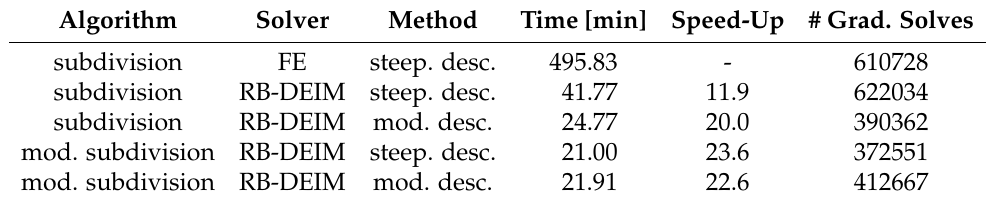
Table 6. Total runtime, number of function, and gradient evaluations for the different methods and the speed-up.